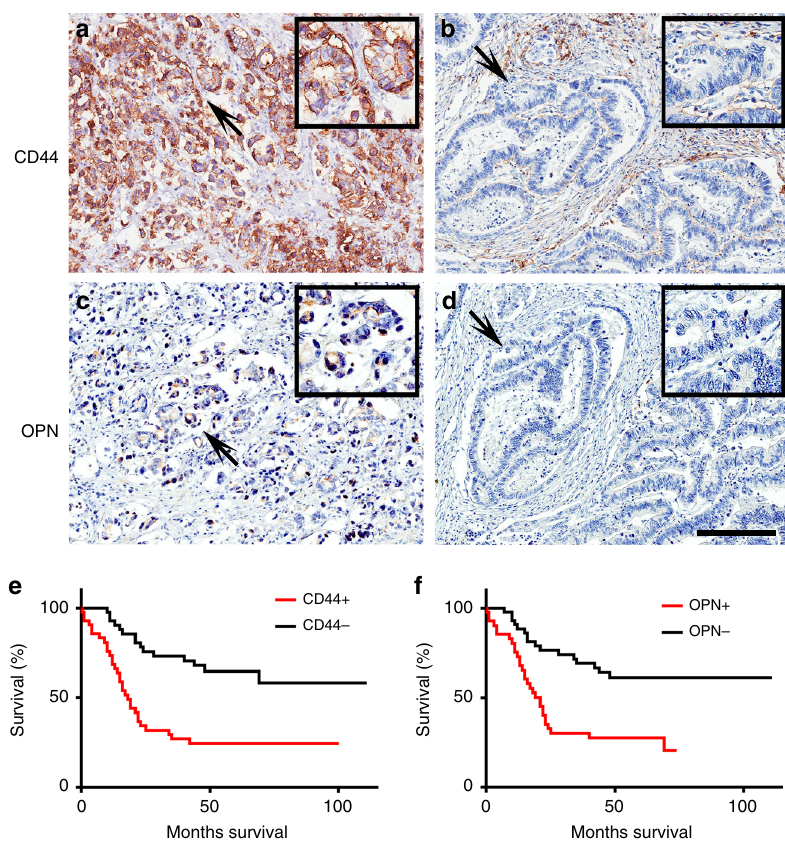
Fig. 6 CD44 and OPN expression in human GEJ cancer correlates with the worse survival of patients. Representative images of cancer cells with ( a , c ) and without CD44 ( a , b ) and OPN (c , d ) expression. Arrows indicate areas shown in insets. e , f Kaplan – Meier survival analysis of GEJ cancer patients with CD44 ( e , CD44 + n = 42, CD44 − n = 42, P < 0.0001) and OPN ( f , OPN + n = 41, OPN − n = 43, P = 0.0002) expression. Combined data set. Elite ABC method and hematoxylin counterstaining ( a – d ). Scale bar in d represents 200 μ m ( a – d ) and 100 μ m (insets in a – d ). Source data are provided as a Source Data fi le.